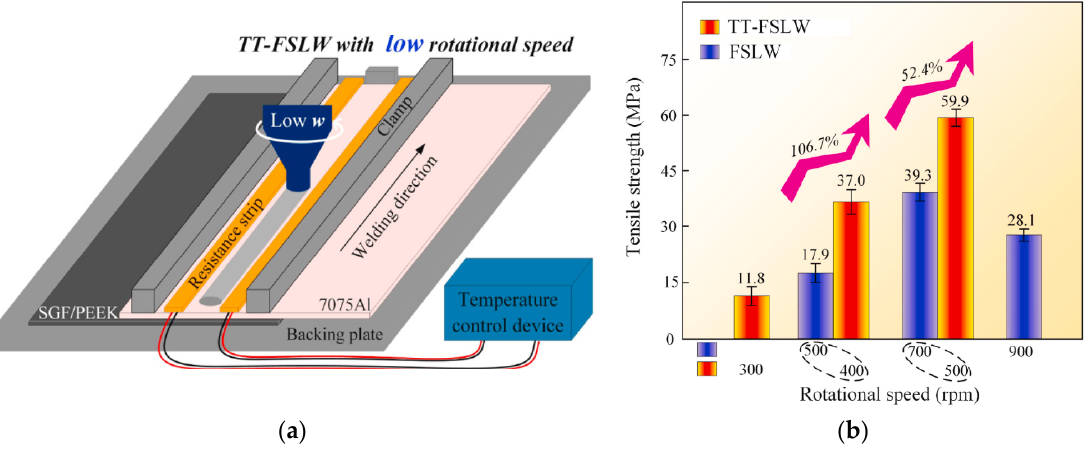
Figure 10. ( a ) Schematic diagram of the TT-FSLW process; ( b ) effect of rotation velocity on tensile shear strengths of joints under different processes. Reprinted with permission from Ref. [87]. 2021, M. Li et al.